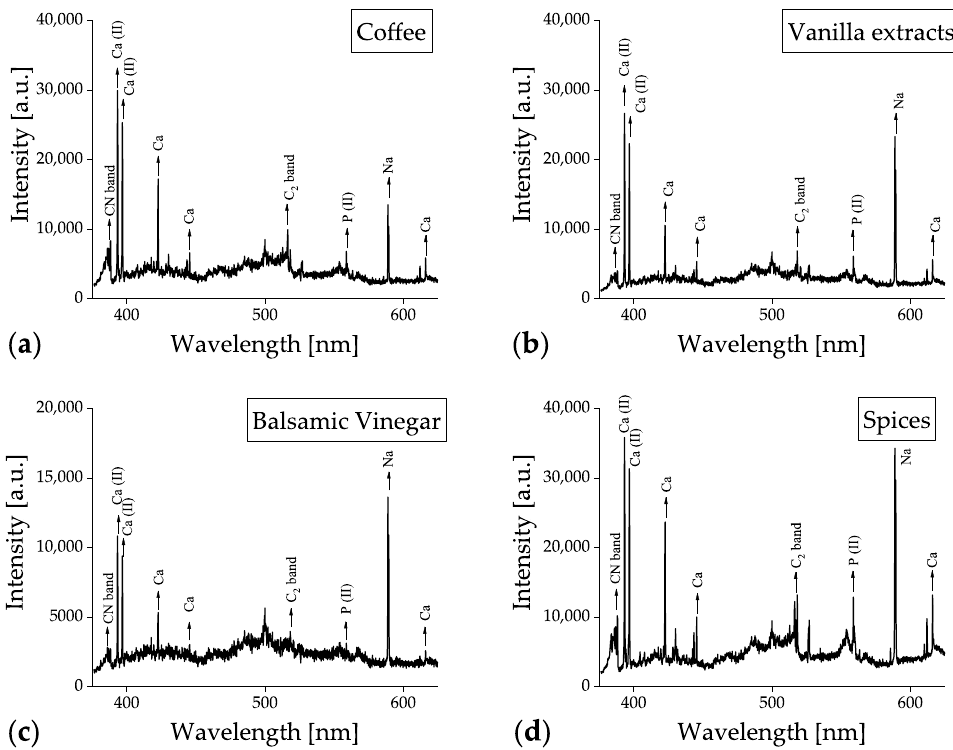
Figure 4. Averaged raw LIBS spectra of ( a ) coffee, ( b ) vanilla extract, ( c ) balsamic vinegar, and ( d ) spice samples collected using the benchtop LIBS system.